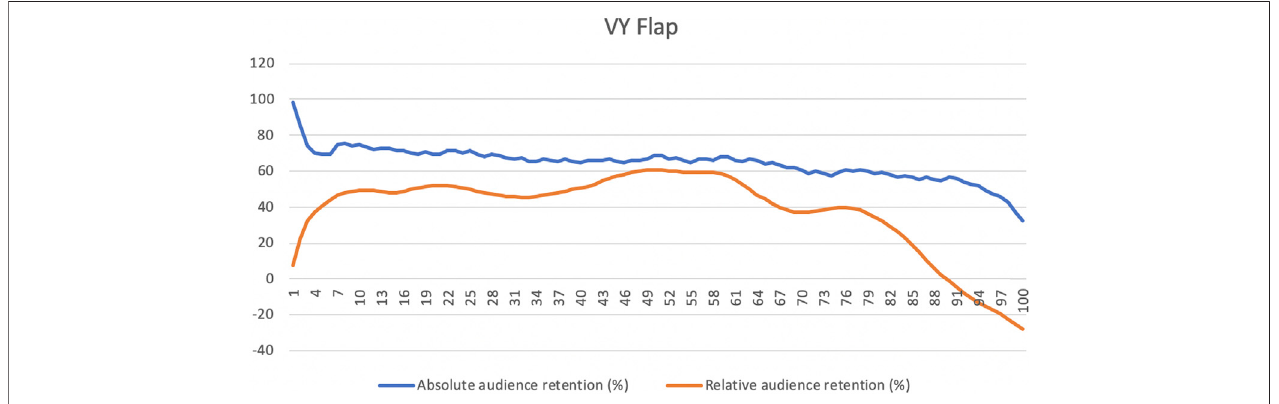
FIGURE 12 | Audience Retention Rate for VY Flap. *The x -axis of the graph refers to the length of the video in percentage.